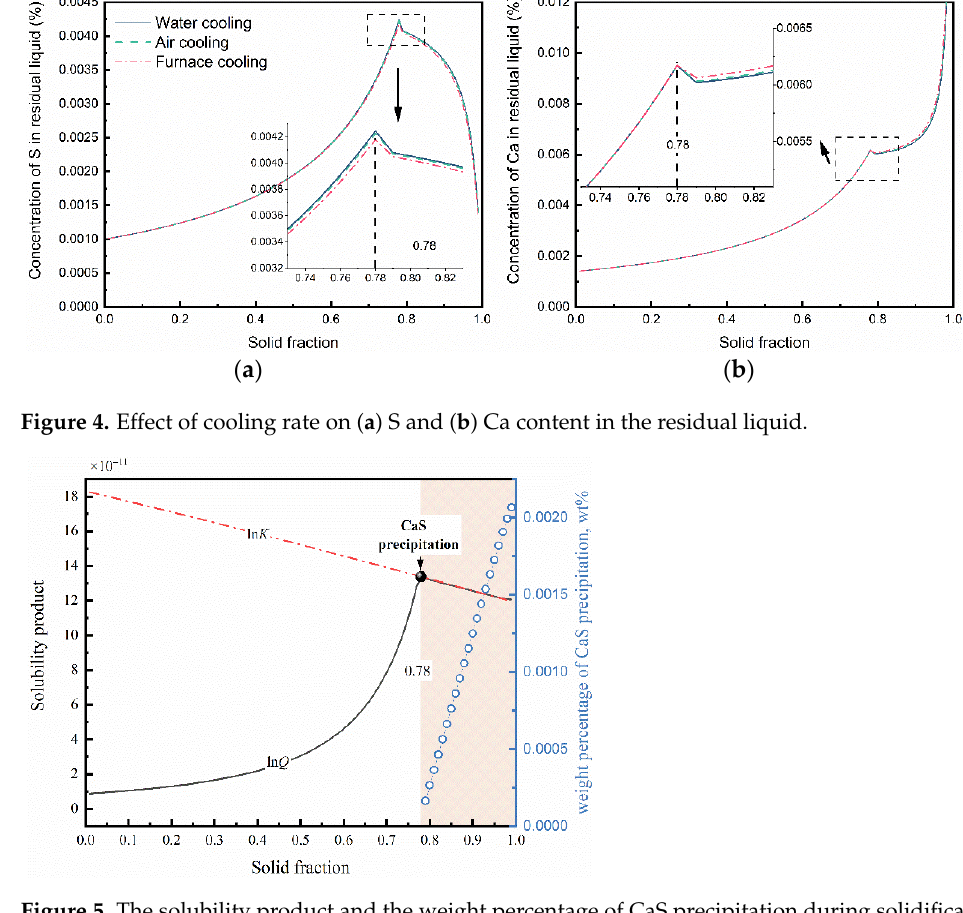
Figure 5. The solubility product and the weight percentage of CaS precipitation during solidification of Invar alloy.